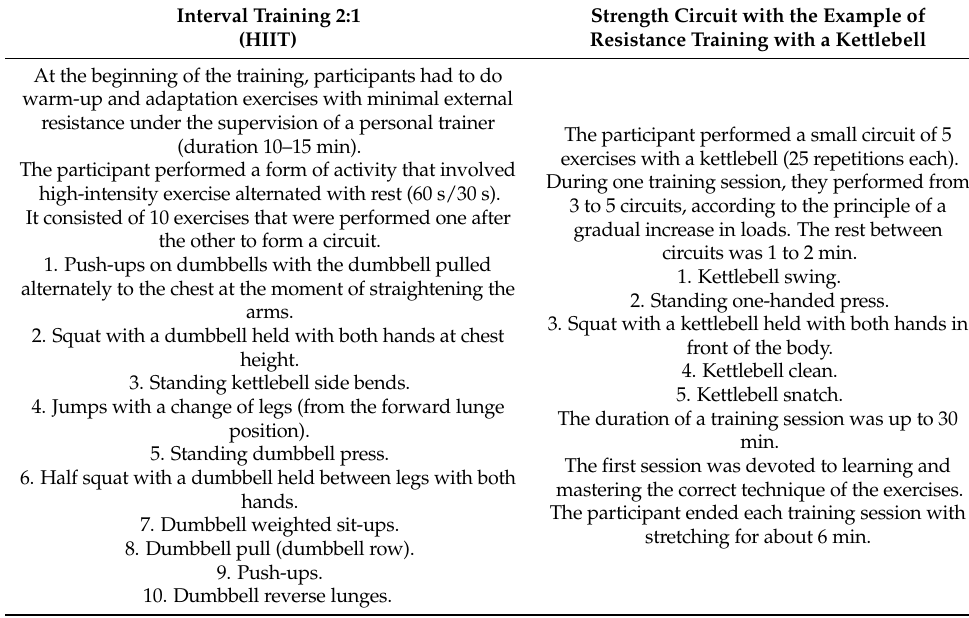
Table 2. Description of exercises of the strength and endurance training program performed by the experimental group